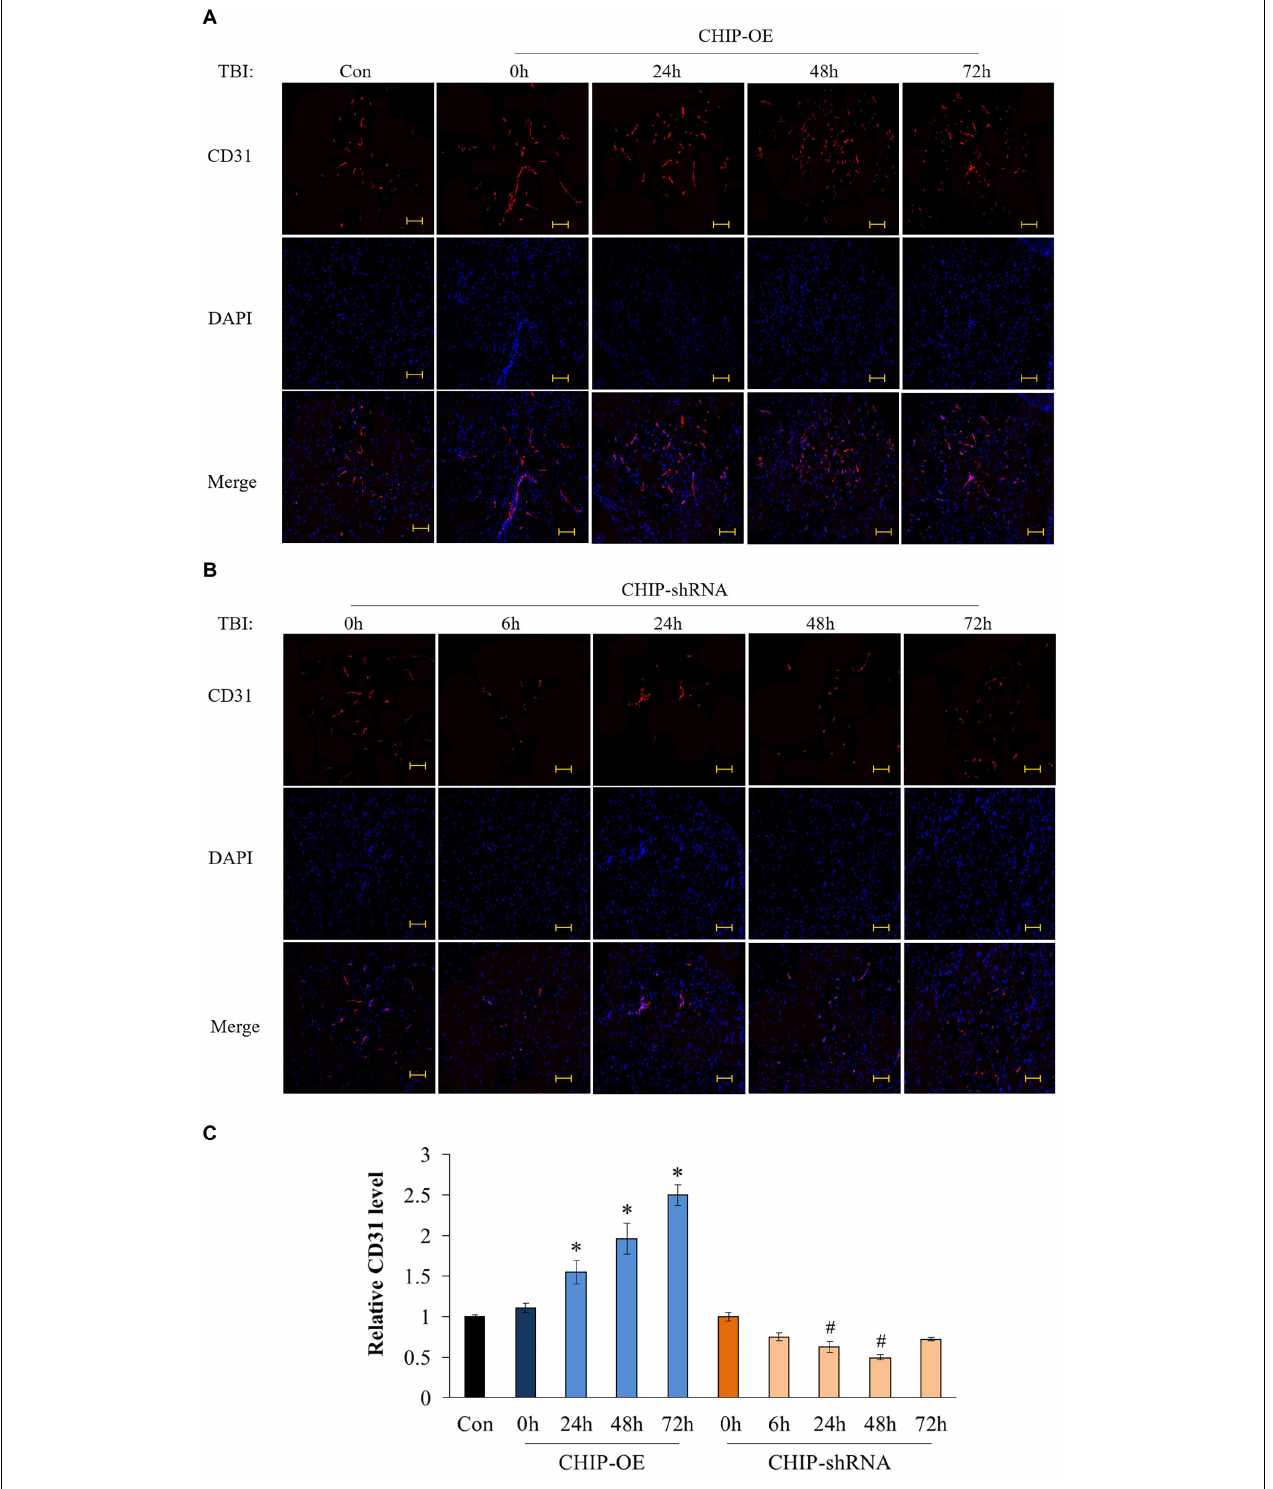
FIGURE 6 | C terminus of Hsc70-interacting protein (CHIP) overexpression increased micrangium density in pericontusional areas after in vivo traumatic brain injury. (A) Immunofluorescence results of CD31 in pericontusional cortex after 0, 24, 48, and 72 h of CCI in CHIP-OE group. (B) Immunofluorescence results of CD31 in pericontusional cortex after 0, 6, 24, 48, and 72 h of CCI in CHIP-shRNA group. (C) Relative expression levels of CD31. CHIP-OE 24, 48, and 72 h vs. CHIP-OE-0h, ∗ p < 0.05; CHIP-shRNA 6, 24, 48, and 72 h vs. CHIP-shRNA-0h, # p < 0.05. Scale bars: 50 µ m.